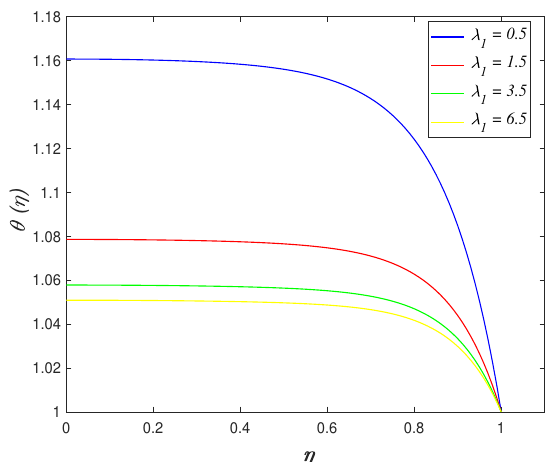
Figure 8. Impact of λ 1 on